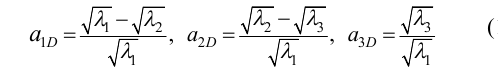
Figure 2. Road extraction results. (a) ground points (black), (b) road center points detected by MS.